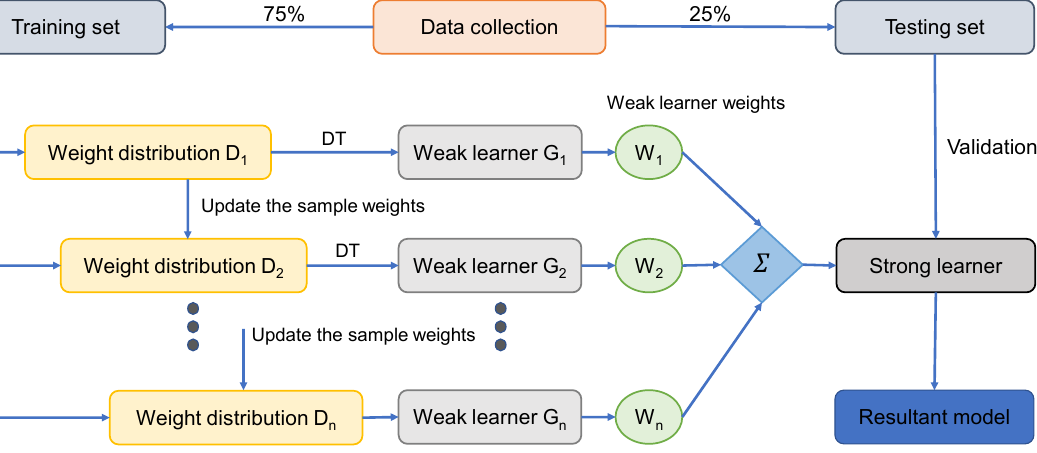
Figure 5. Schematic representation of AdaBoost technique.